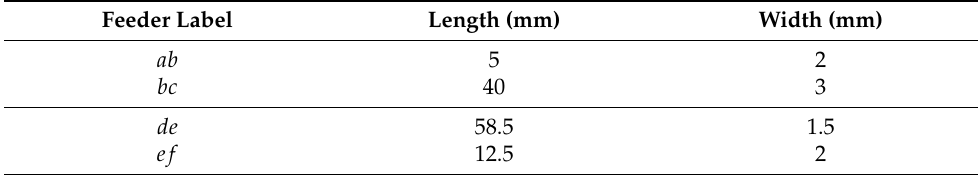
Figure 8. Schematic diagram of the feeding line design. Table 2. Design parameters of the multilayer patch antenna sensor.